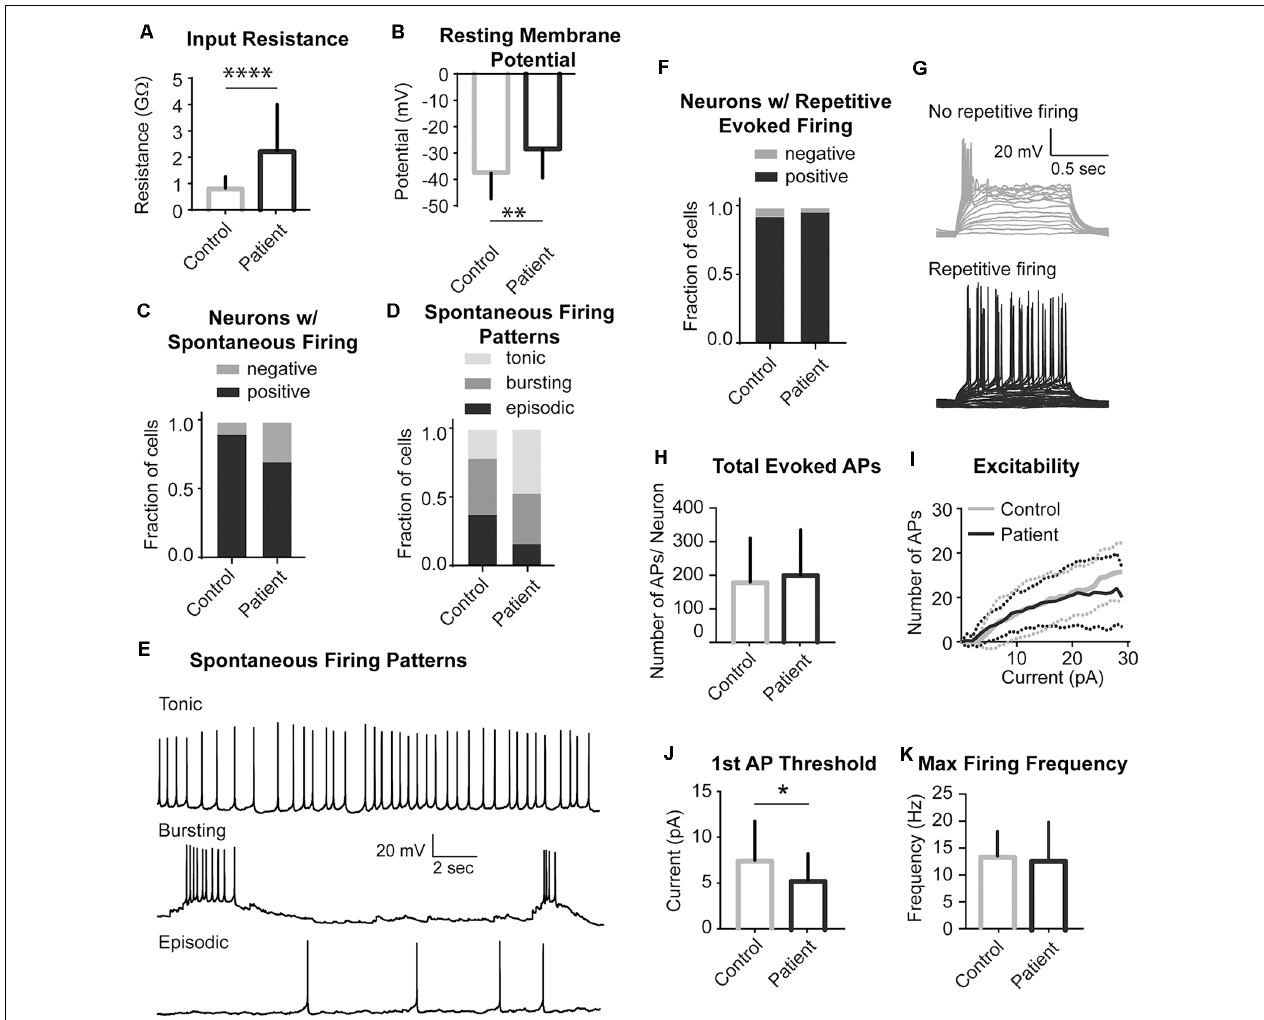
FIGURE 5 | Electrophysiological properties of PS patients and control neurons. (A) Summary data of Input Resistance, data represented as Mean ± SEM; sample sizes: Control (gray bar) n = 31, Patient (black bar) n = 27; Unpaired Student’s t -test, ∗∗∗∗ p < 0.0001. (B) Summary data of Resting Membrane Potential, data represented as Mean ± SEM; sample sizes: Control (gray bar) n = 31, Patient (black bar) n = 27; Unpaired Student’s t -test, ∗∗ p = 0.0016. (C) The fraction of neurons firing spontaneously at − 40 mV, data represented as a fraction of the total cell number; black bar- neurons with spontaneous firing, gray bars- neurons with no spontaneous firing; sample sizes: Control n = 31, Patient n = 27; Fisher’s exact test, p = 0.0913 (n.s.). (D) Distribution of the pattern of spontaneous firing represented as fraction of total of all cells with spontaneous firing; sample sizes: Control = 28, Patient = 19; Chi-square test χ = 3.987, df = 2, p = 0.1362 (n.s.). (E) Example recordings of three different spontaneous firing patterns: Tonic, Bursting and Episodic. (F) A fraction of neurons firing repetitive evoked action potentials (APs), data represented as a fraction of the total cell number; black bar- neurons with repetitive firing, gray bar- neurons with no repetitive firing; sample sizes: control n = 28, Patient n = 26; Fisher’s exact test, p > 0.999 (n.s.). (G) Example recordings of a series of depolarizing current injections to a neuron demonstrating no repetitive firing (top gray traces) and a neuron firing repetitively (bottom black traces). (H) Summary data of the Total Evoked APs, data represented as Mean ± SEM; sample sizes: Control (gray bar) n = 27, Patient (black bar) n = 22; Unpaired Student’s t -test, p = 0.5634 (n.s). (I) Input-Output curves characterizing excitability of neurons derived from control and mutant neurons, data represented as the mean number of APs (Y-axis) evoked with a given current injection (X-axis); sample sizes: Control (solid gray line) n = 27, Patient (solid black line) n = 22, dotted lines represent the range of SEM for each experimental group; multiple t -tests for each current step, adjusted p values n.s. (J) Firing threshold represented as minimum current required to evoke action potential (AP) firing, data represented as Mean ± SEM; sample sizes: Control (gray bar) n = 26, Patient (black bar) n = 22; Unpaired Student’s t -test, * p = 0.0468. (K) Maximum Evoked Firing Frequency, data represented as Mean ± SEM; sample sizes: Control (gray bar) n = 26, Patient (black bar) n = 22; Unpaired Student’s t -test, p = 0.8784 (n.s.). For all recordings, no differences were found between the two patient lines and they were